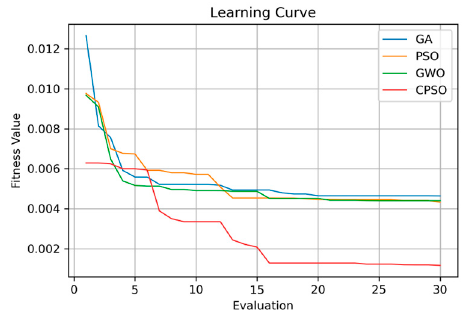
Figure 15. Learning curves of different optimizers.